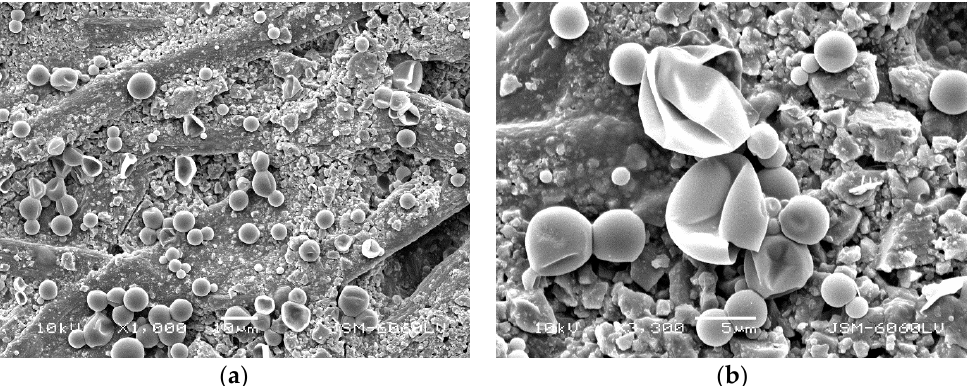
Figure 8. Pressure-activated citronella oil microcapsules: ( a ) produced with complex coacervation (SEM, 900×); ( b ) produced with in situ polymerization (SEM, 5000×).